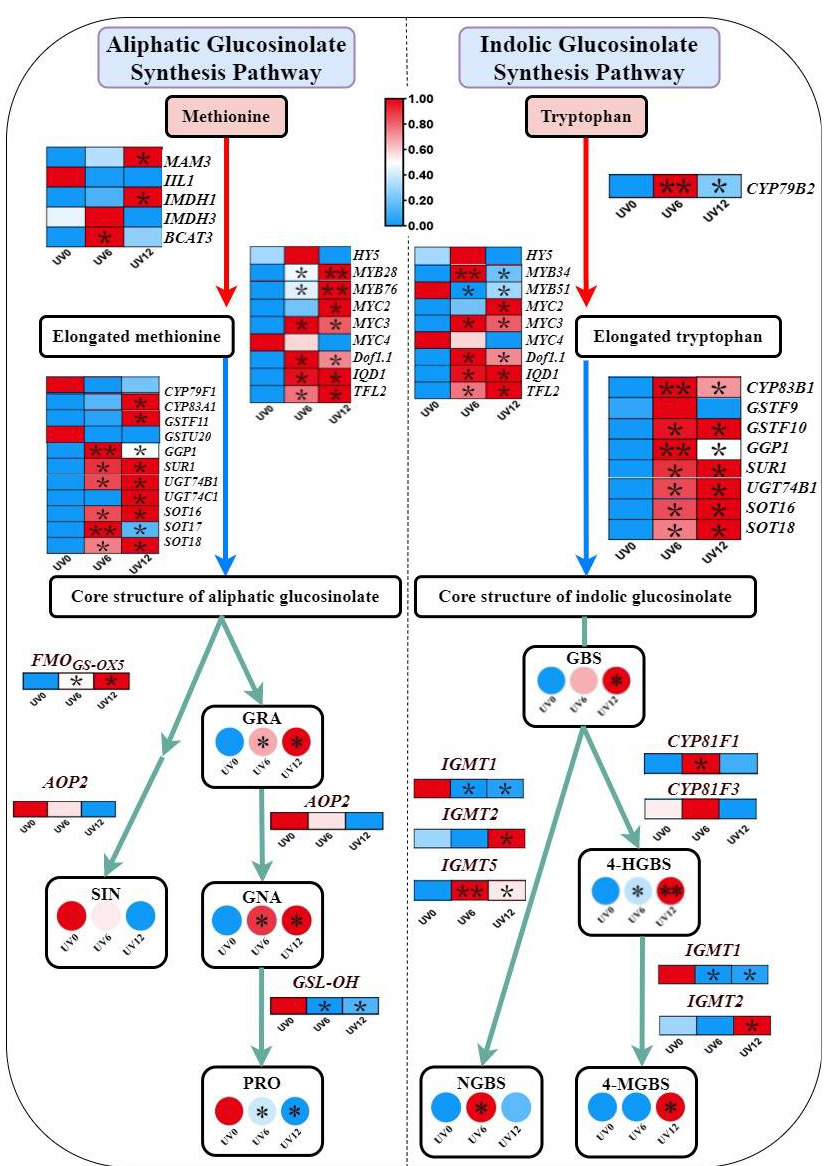
Figure 12. Expression pattern diagram of genes associated with GSL biosynthesis in plants subjected to different UVA-radiation exposure durations. The red arrows indicate amino acid chain extension, while the blue arrows indicate glucosinolate core structure formation, and the green arrows indicate secondary modification of side chains. The rectangles represent genes, and the circles represent glucosinolates. The gene expression levels or the glucosinolate contents ranged from low (blue) to high (red). * and ** indicate that the relative gene expression or glucosinolate content was significantly increased or decreased by UV6 and UV12 compared with UV0 at p ≤ 0.05 and at p ≤ 0.01, respectively.